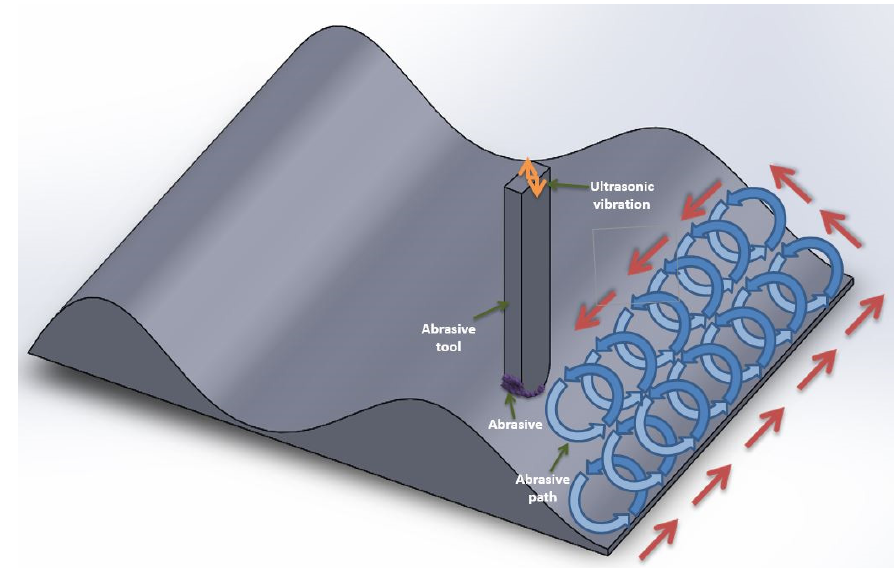
Figure 2. Diagram of the ultrasonic polishing process.